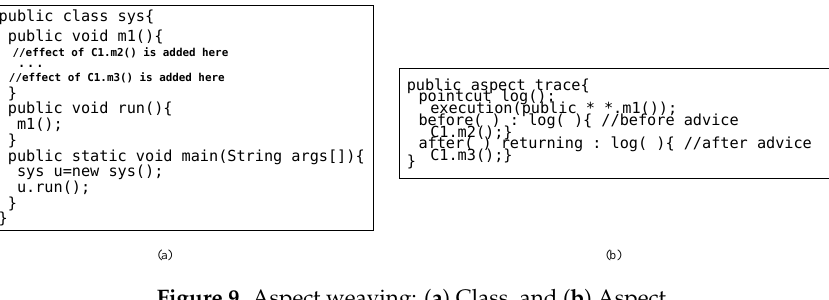
Figure 9. Aspect weaving: ( a ) Class, and ( b ) Aspect.